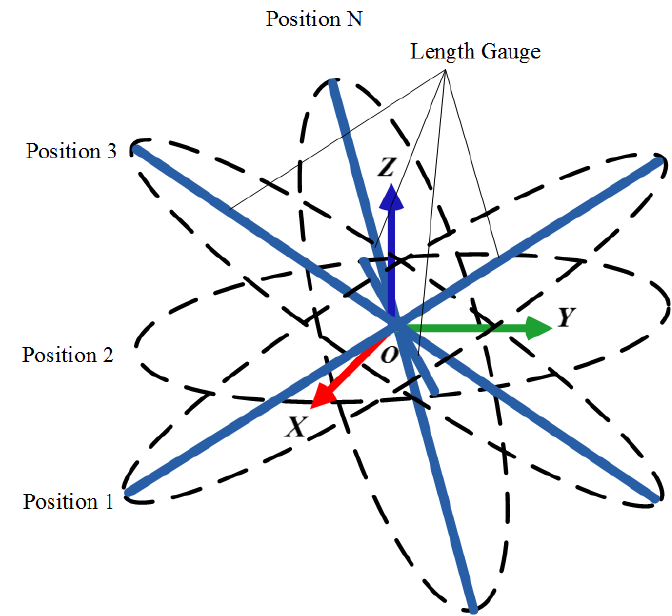
Figure 5. Sample